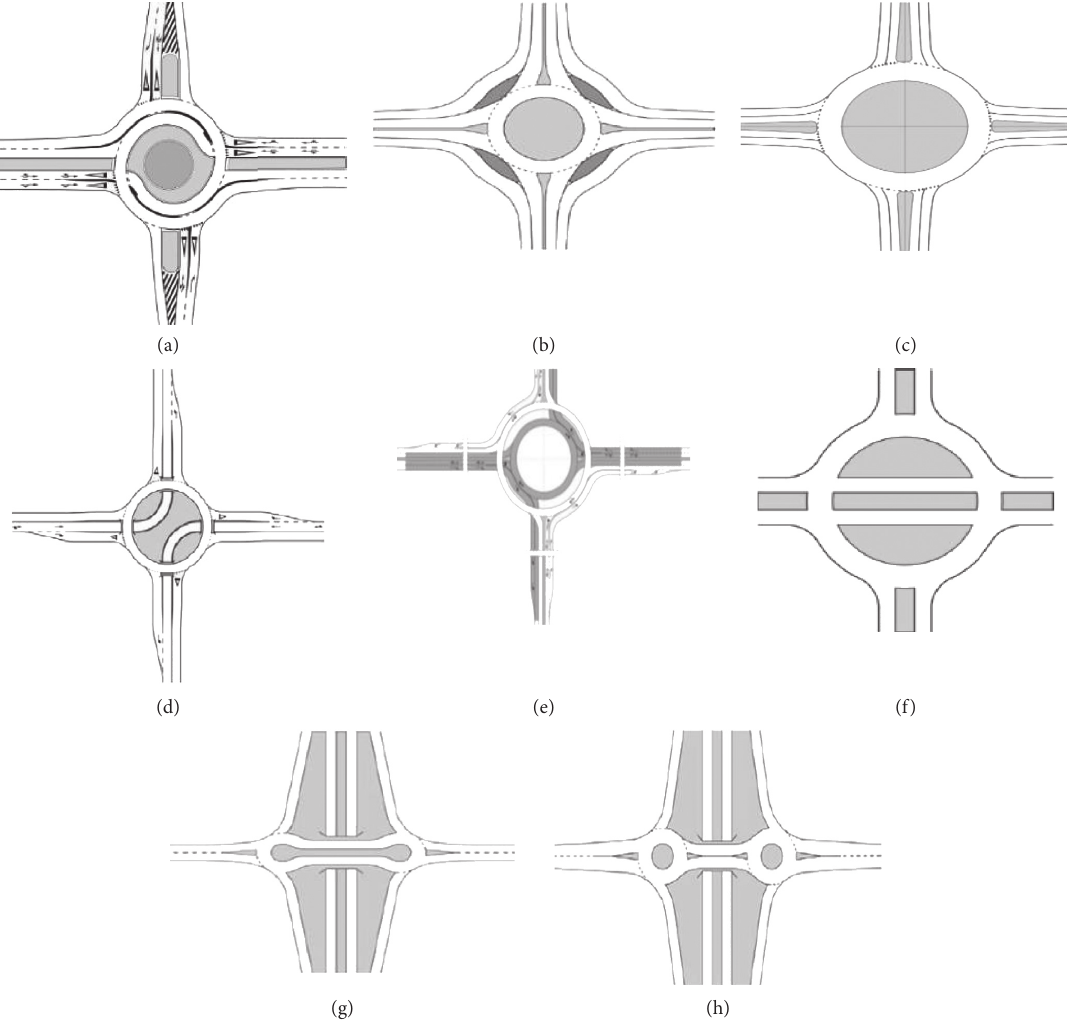
Figure 1: Alternative types of roundabouts. (a) Turbo roundabout. (b) Flower roundabout. (c) Compact roundabout. (d) Four-flyover roundabout. (e) Target roundabout. (f) Throughabout roundabout. (g) Dog-bone roundabout. (h) Dumb-bell